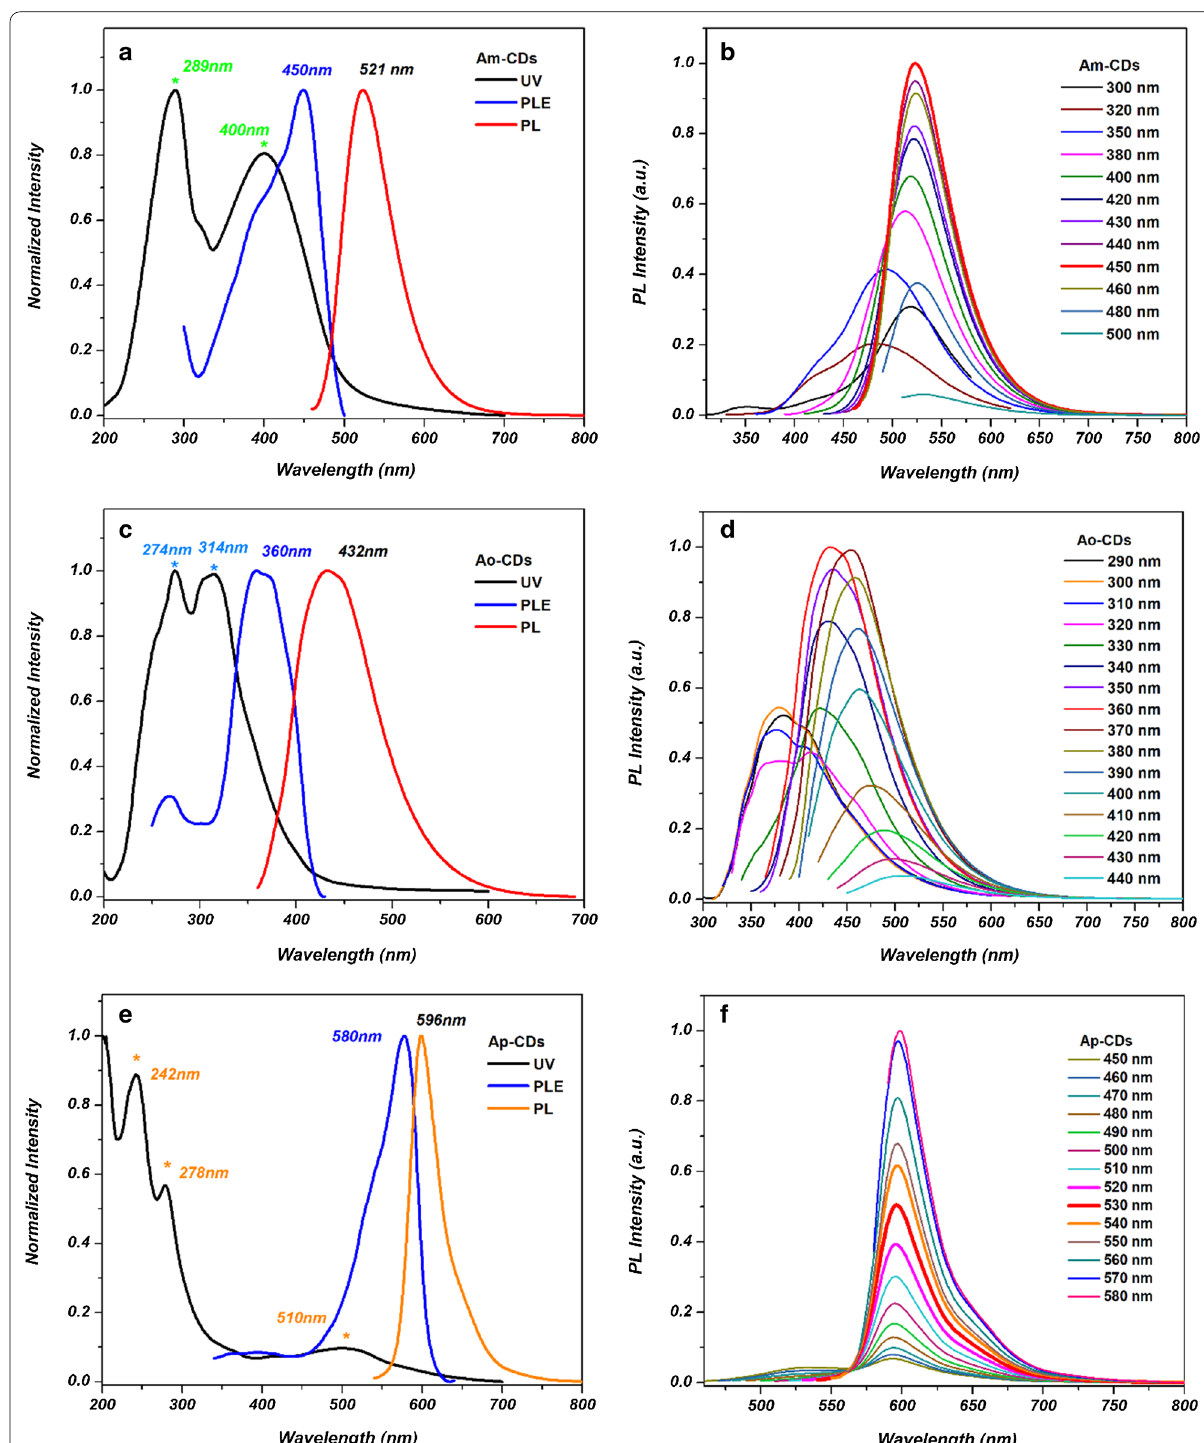
Fig. 7 The normalized UV–Vis absorption spectra, PL excitation, and PL emission spectra of the a A m -CDs, c A o -CDs, and e A p -CDs. The normalized PL emission spectra of the b A m -CDs, d A o -CDs, and f A p -CDs at different excitation